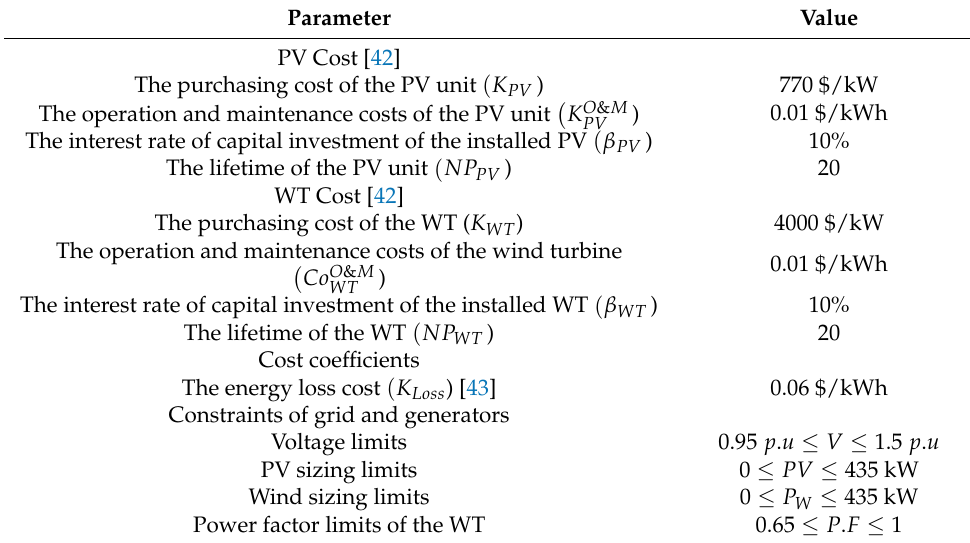
Table 2. The cost coefficients and the system constraints.